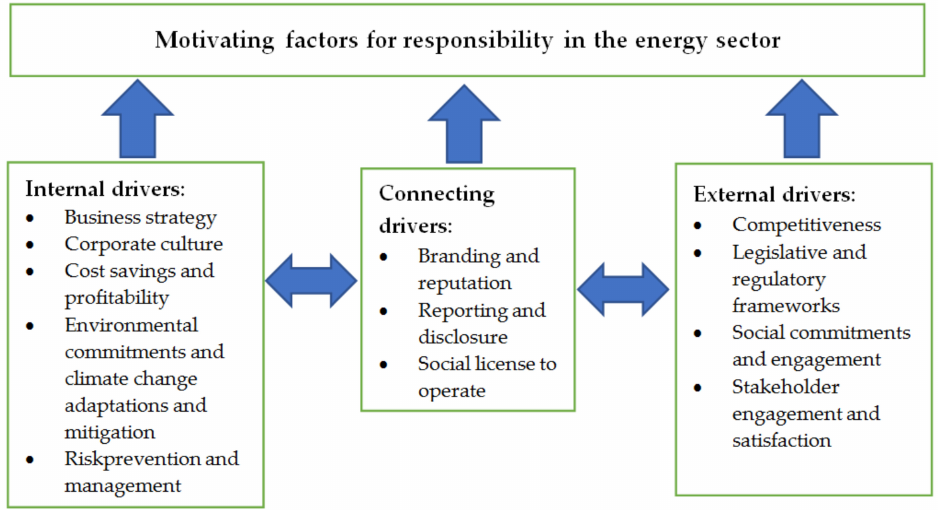
Figure 1. Motivating factors for CSR in the energy sector. Source: own work based on